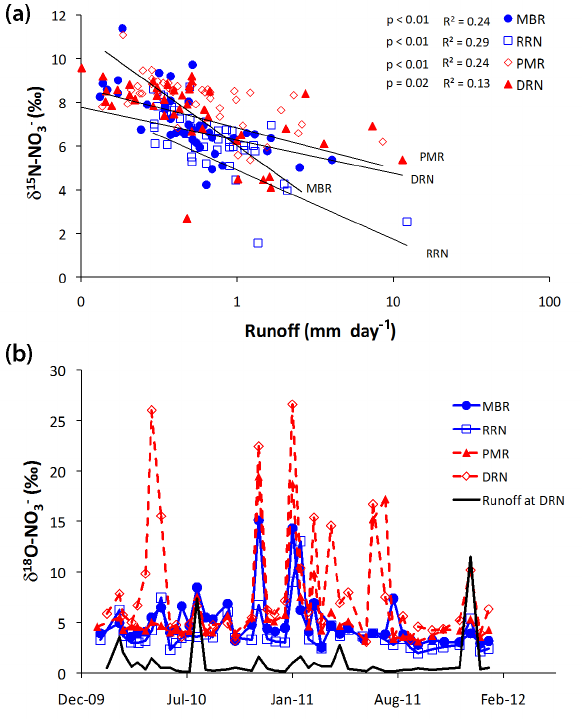
Figure 4. A comparison of (a) runoff vs. δ 15 N-NO − and δ 18 O-NO − vs. 3